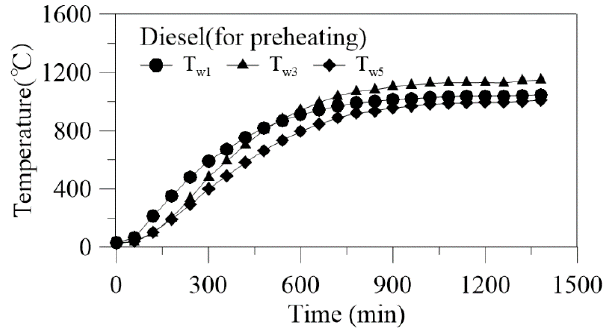
Figure 3. Temperature variations during the preheating process.